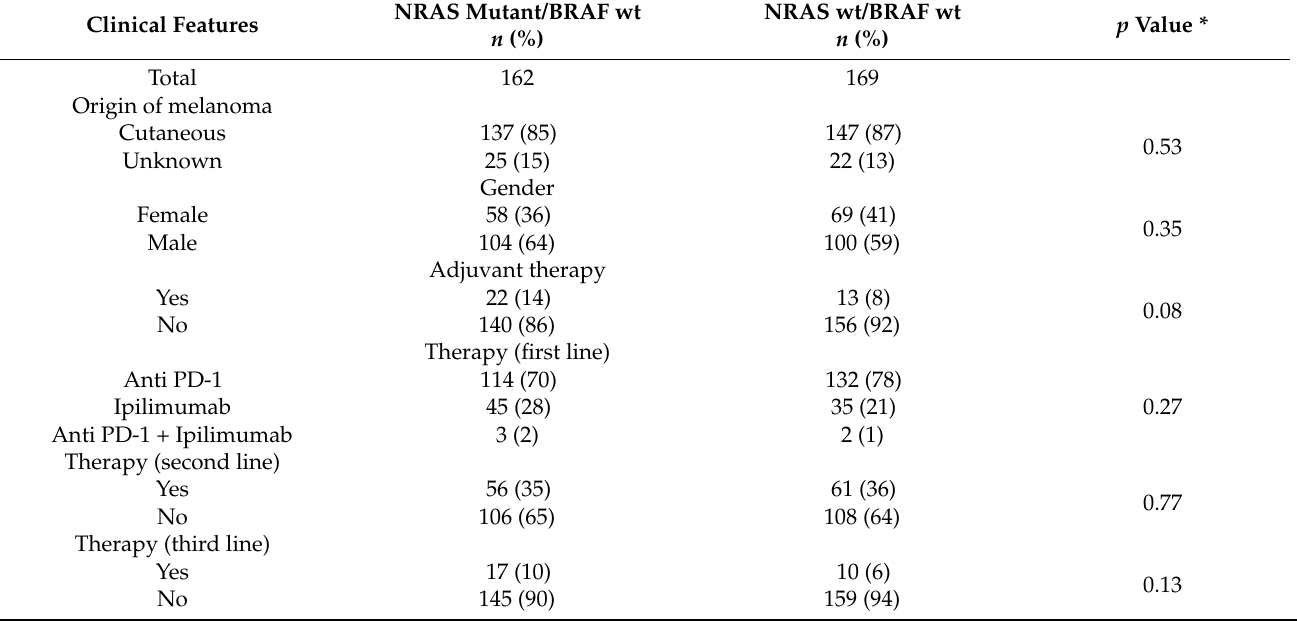
Table 1. Summary of clinical characteristics and treatment selection of the study cohort ( n = 331 patients). Clinical